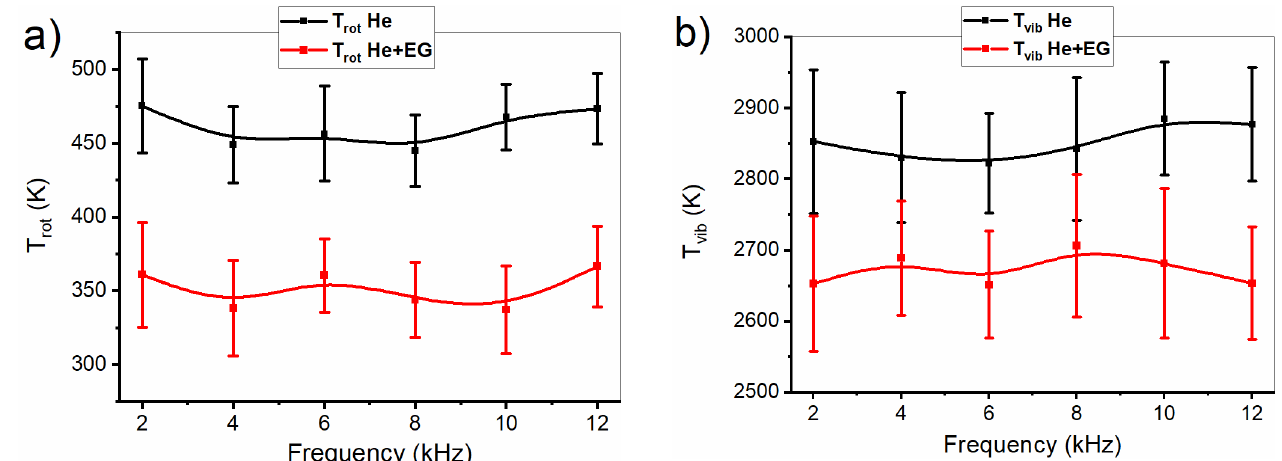
Figure 6. Variations with frequency of the calculated rotational ( a ) and vibrational ( b ) temperatures for DBD operated in He and He/ethylene glycol (EG) vapor mixture. for DBD operated in He and He/ethylene glycol (EG) vapor